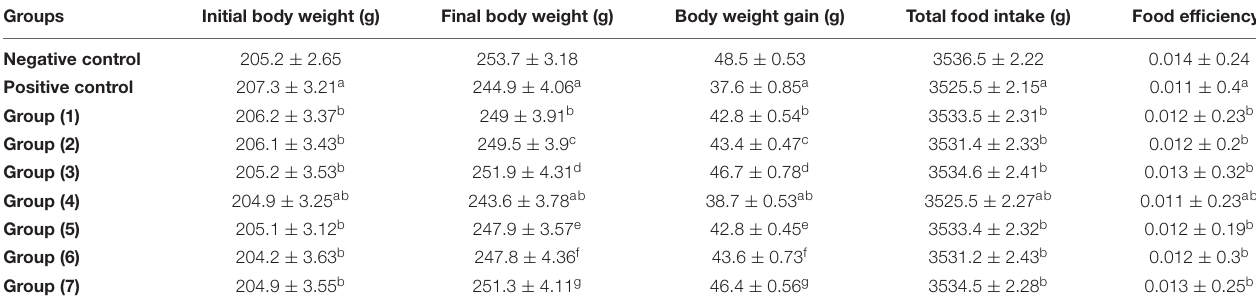
TABLE 5 | Effects of the RB, BR, and SL complex coacervates and UF cheese with coacervates on body weight, body weight gain, total food intake, and food efficiency. Groups